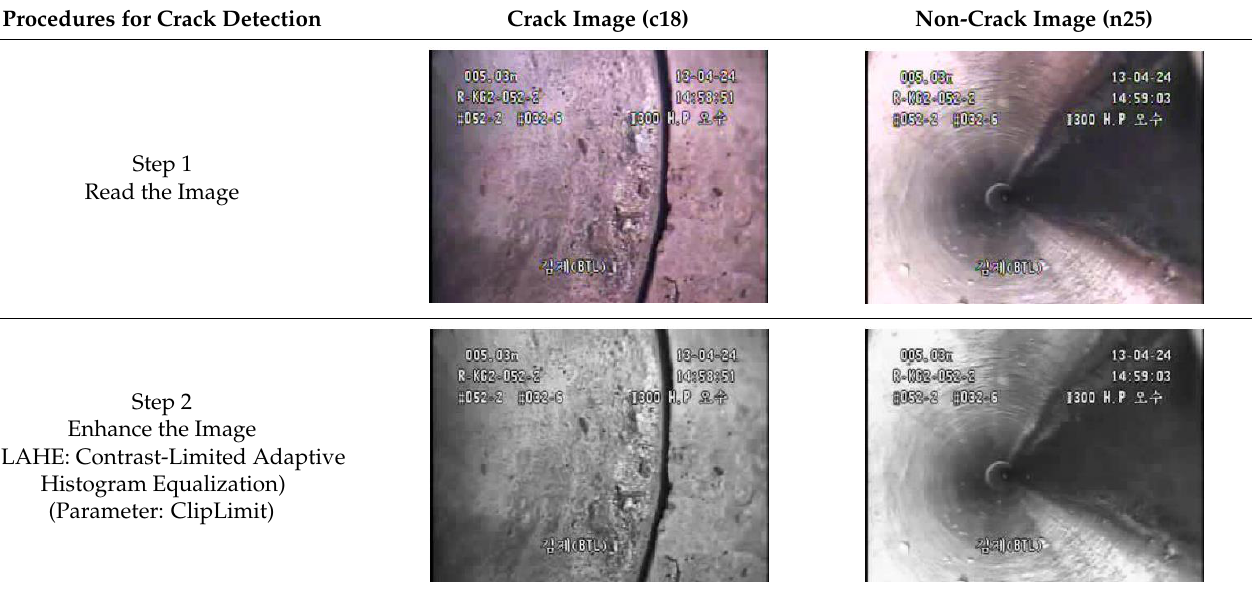
Table 2. Crack detection procedure.